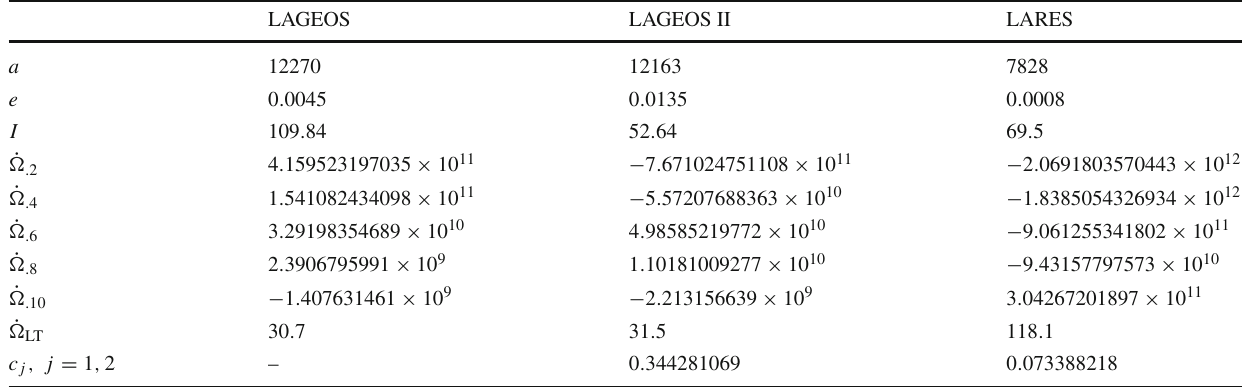
Table 1 Relevant orbital parameters a ( km ), e , I ( deg ) of LAGEOS, LAGEOS II, LARES, their classical node precession coefficients ˙ (cid:2) .(cid:3) for the first five even zonal harmonics ( (cid:3) = 2 − 10), their Lense– Thirring node precessions ˙ (cid:2) LT for S = 5 . 86 × 10 33 kgm 2 s − 1 , and the combination coefficients c 1 , c 2 . All the rates, in mas year − 1 , are